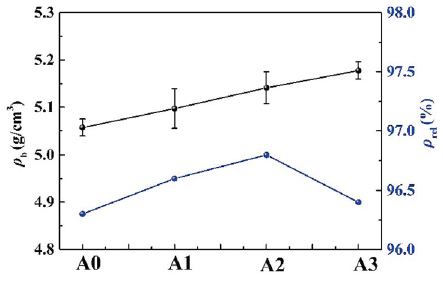
Fig. 5 ρ b and ρ rel of A0, A1, A2, and A3 NTC